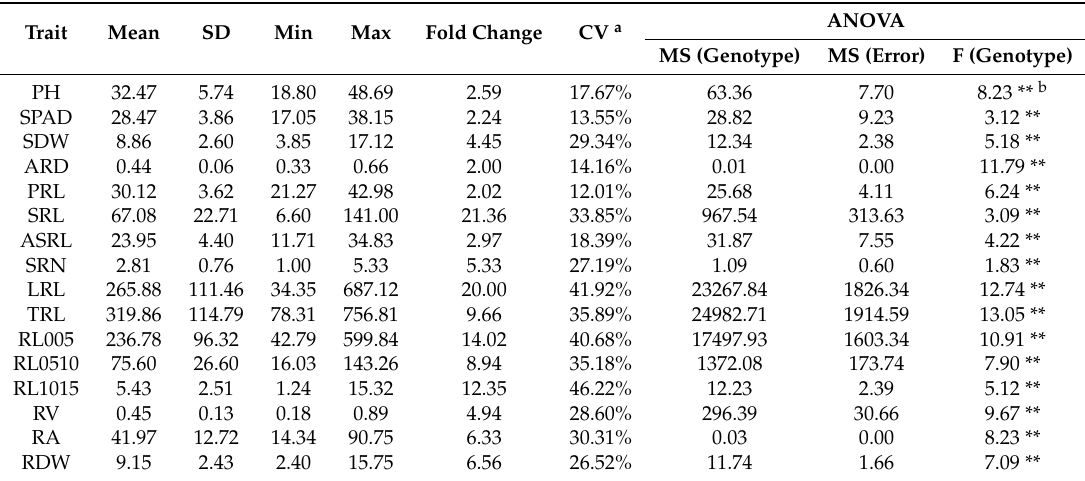
Figure 1. Distribution of root and shoot traits in 297 maize inbred lines. Table 2. Phenotypic variation for root and shoot traits of 297 maize inbred